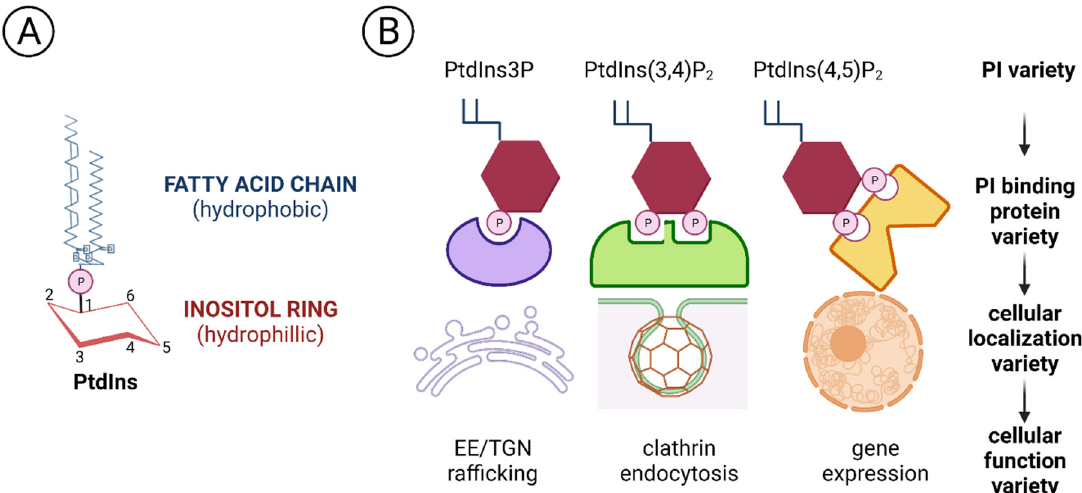
Figure 4. Structure of phosphatidylinositol (PPIns) ( A ) PtdIns is formed by an hydrophilic inositol ring bound to two hydrophobic fatty acid chains. ( B ) Different phosphoinositols can be bound by different specific effector proteins to regulate different cellular functions (modified by [28]).